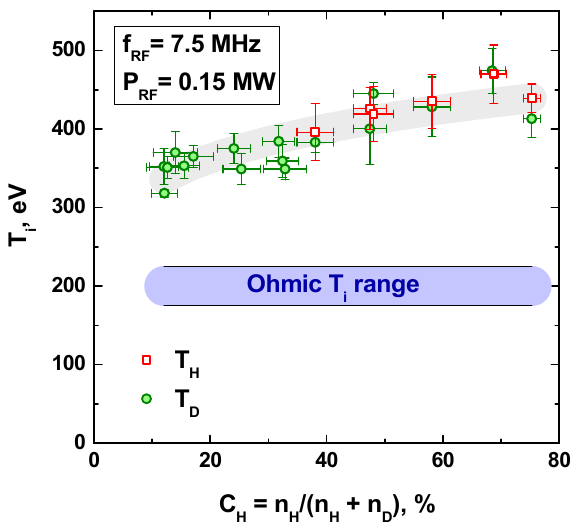
Figure 6. Ion temperature as a function of the H minority concentration in ICRH experiments (discharges ##13773–13801 with different n H / n D ratio). Here, T H and T D are the temperatures of hydrogen and deuterium ions in an ICRH experiment, and wide blue line is the ion temperature in the Ohmic regime. The figure is taken from [41] and reproduced with permission from Springer